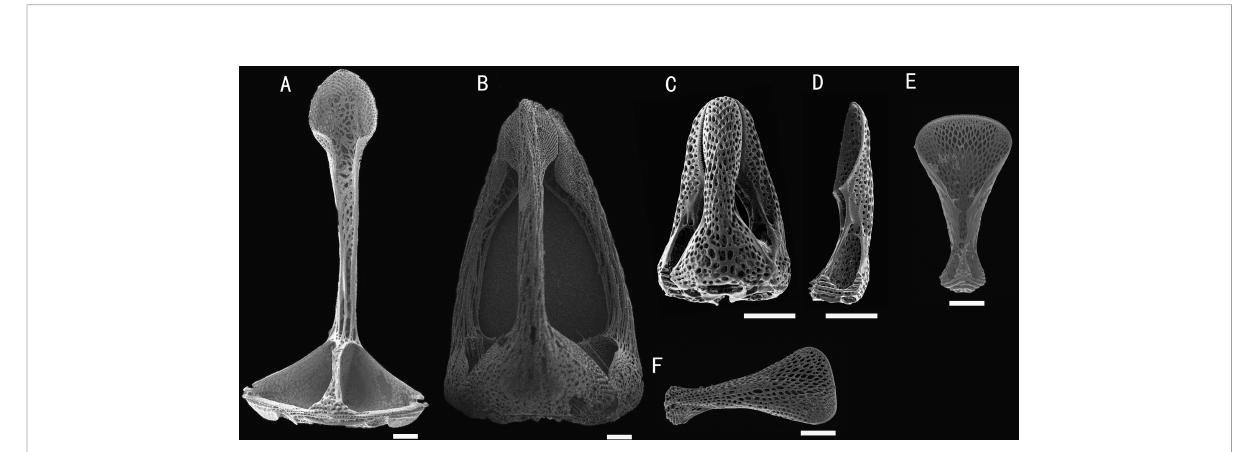
FIGURE 4 Hygrosoma involucrum sp. nov.; holotype, MBM286973. SEM images of pedicellariae. (A, B) Large involute tridentate pedicellaria: (A) individual valve (B) head. (C, D) Small involute tridentate pedicellaria: (C) head (D) individual valve. (E, F) Valves of triphyllous pedicellariae. Scale bar , 100 m